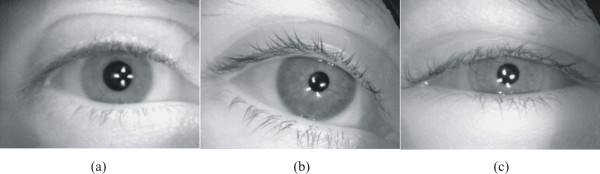
Recorded IR-illuminated images of the eye of three subjects showing the pupil at its maximum miosis for (a) healthy volunteer, (b) diabetic subject without CAN, and (c) diabetic subject with CAN.